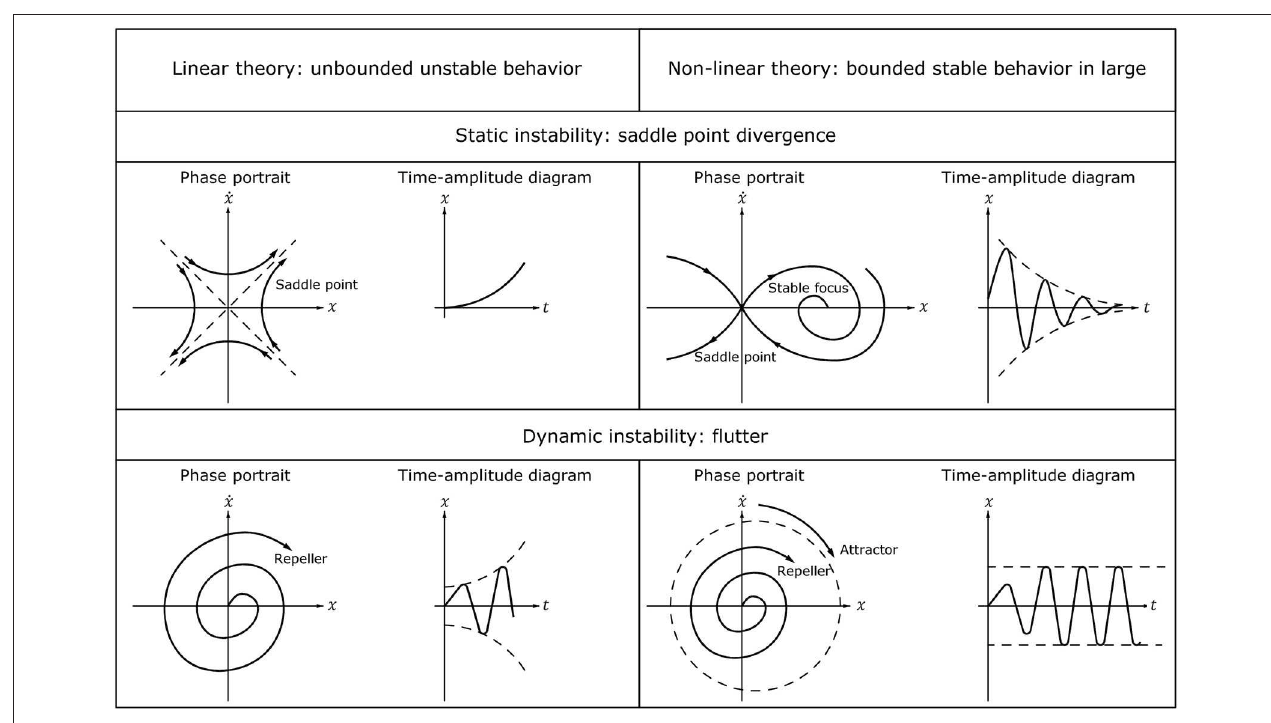
FIGURE 6 | A comparison between linear and non-linear investigations of static and dynamic